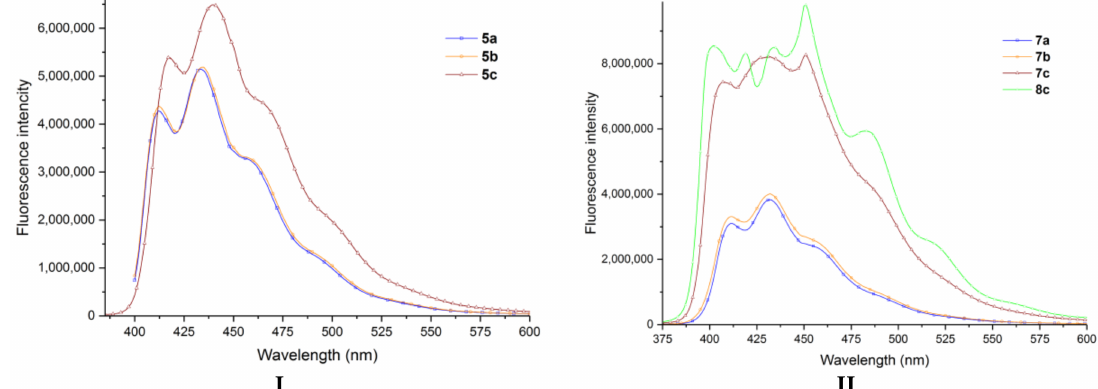
Figure 5. The emission spectra recorded in cyclohexane solution of the azasteroid derivatives: ( I )- 5a – c ; ( II )- 7a – c and 8c